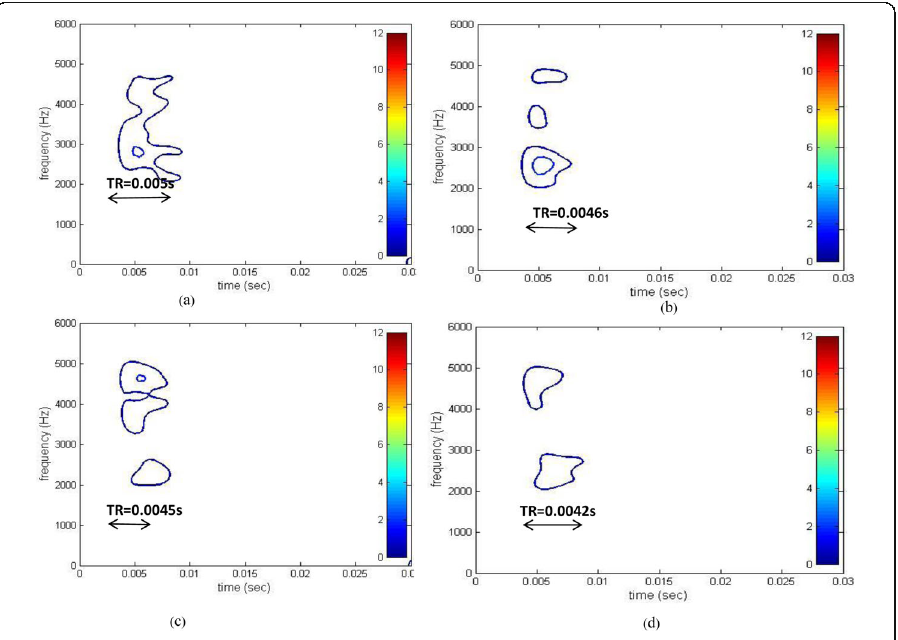
Fig. 16 Case 1: no cavity. a Sensor at 5 cm. b Sensor at 10 cm. c Sensor at 15 cm. d Sensor at 20